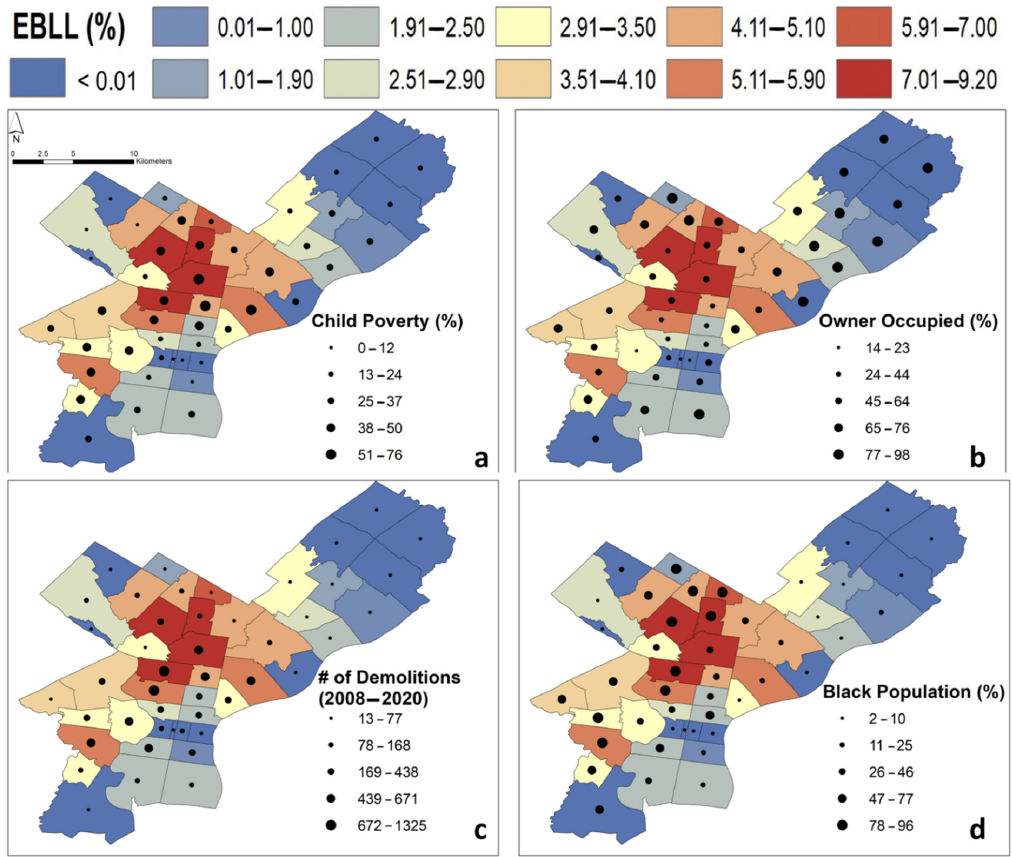
Figure 7. Bivariate plots demonstrating % EBLL compared with % children in poverty (dots) ( a ); % EBLL compared with % owner-occupied properties (dots) ( b ); % EBLL compared with the number of demolitions (dots) ( c ); and % EBLL compared with % Black population (dots) ( d ).